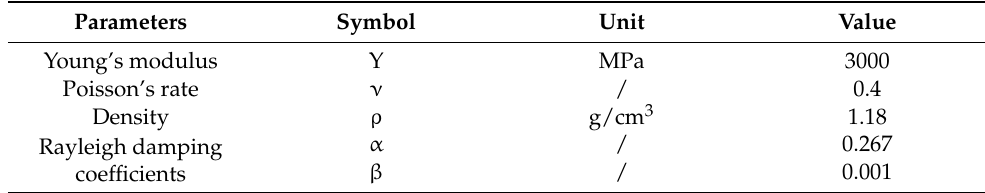
Table 1. The material properties of the model.